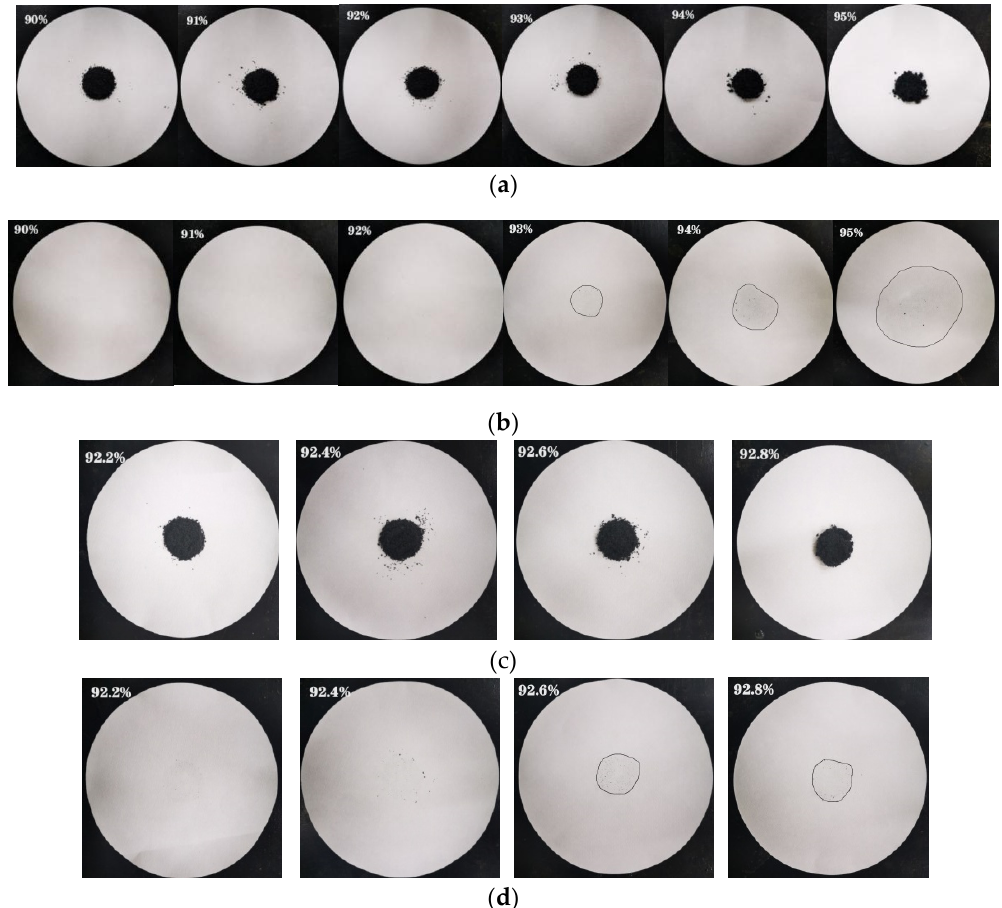
Figure 1. Photographs of CA–MA/EG samples before and after thermal treatments. ( a ) The first group of samples after thermal treatment, ( b ) the first group of filter papers with specimens brushed off after thermal treatment, ( c ) the second group of samples after thermal treatment, (d) the second group of filter papers with samples brushed off after thermal treatment.